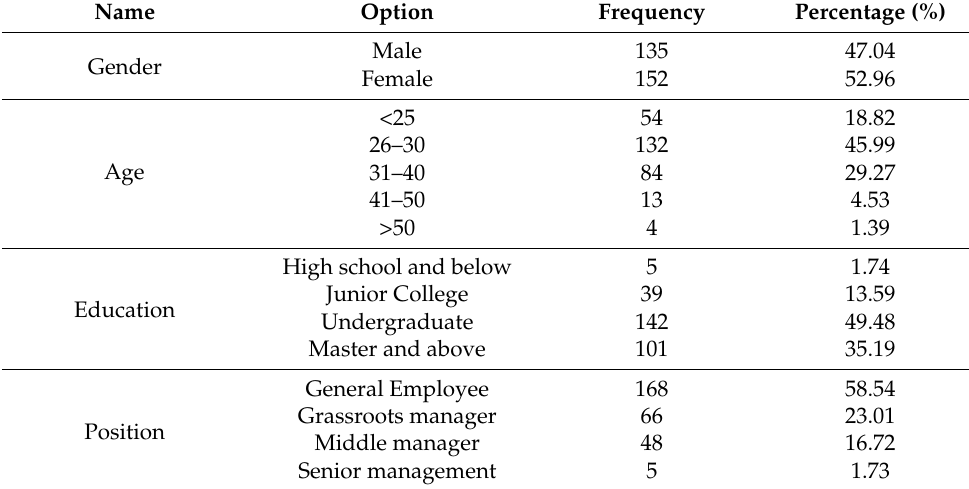
Table 4. Descriptive Statistics of Basic